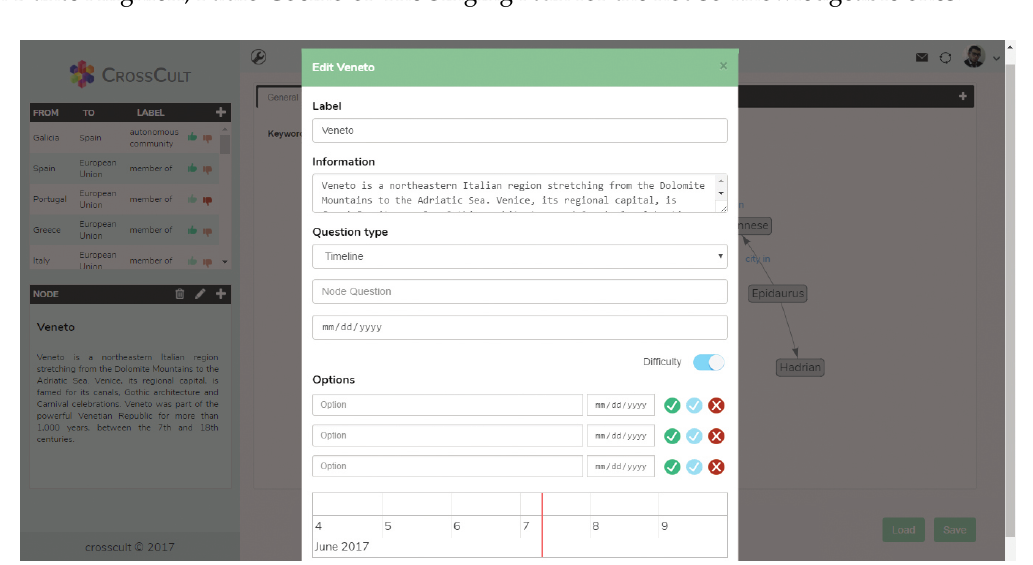
Figure 10. Edition of informational snippets and multiple-choice